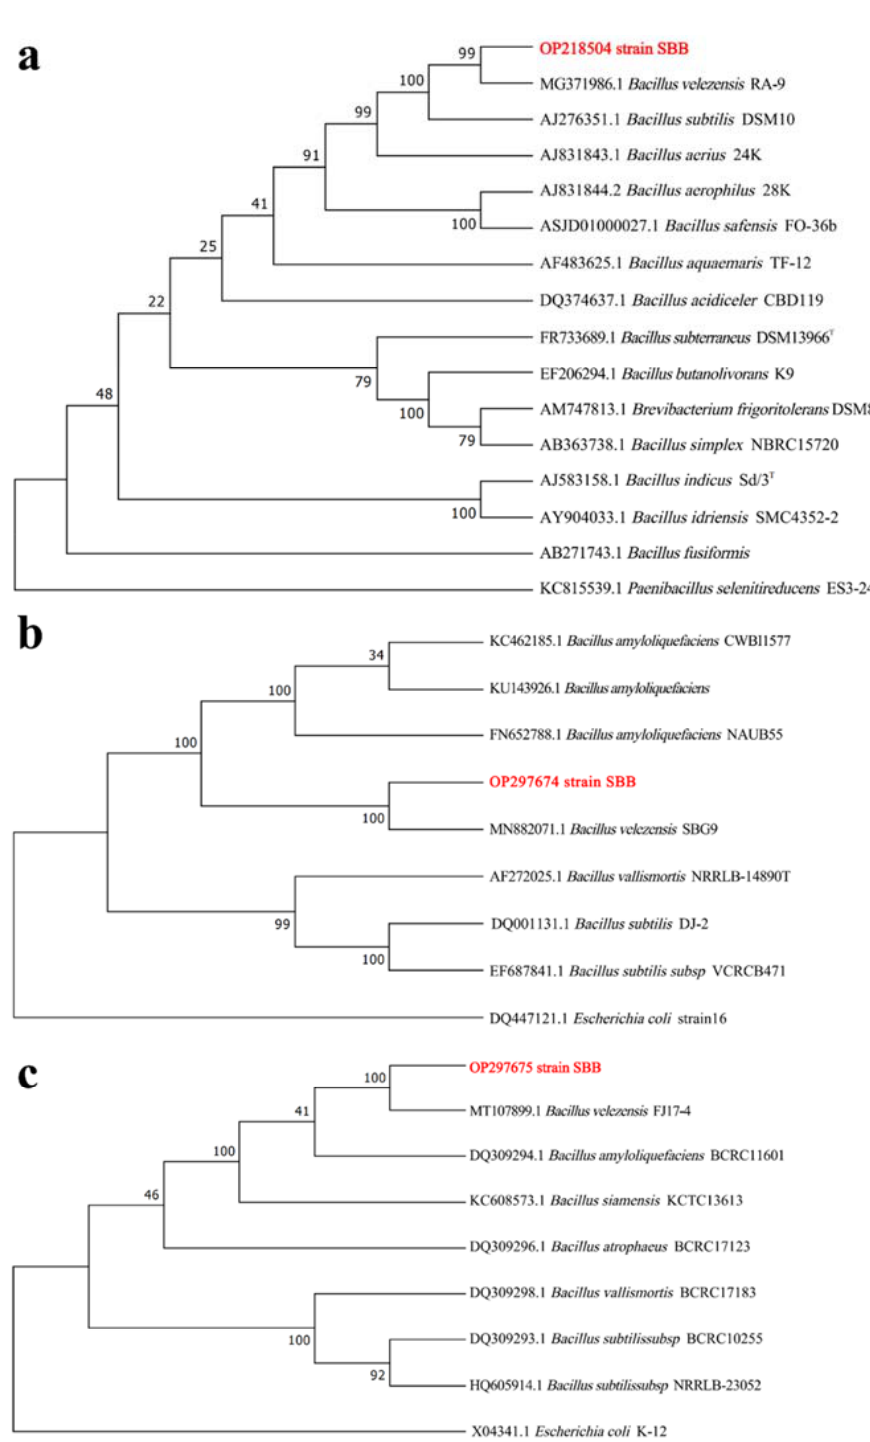
Figure 1. Phylogenetic tree of Bacillus sp. SBB based on ( a ) 16S rRNA, ( b ) gyrA , and ( c ) gyrB gene sequences. Paenibacillus selenitireducens ES3-24, Escherichia coli K-12, and E. coli strain 16 were selected as outgroups for the 16S rRNA, gyrA , and gyrB phylogenetic trees,